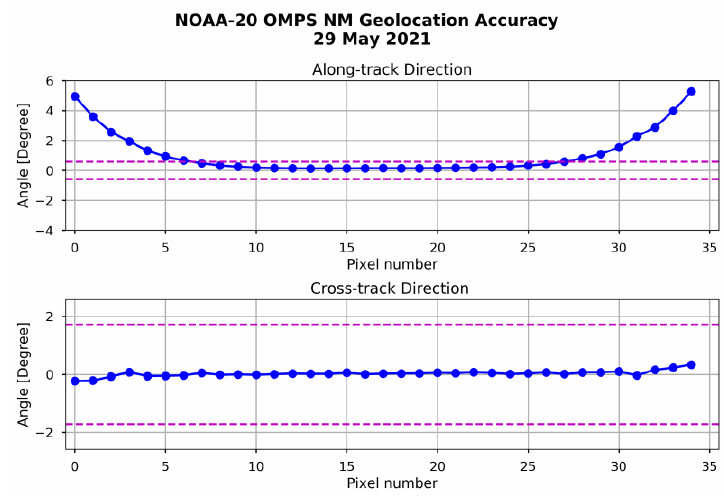
Figure 11. Geolocation assessment results, including the offset angles in the along-track and cross- track directions, where the dashed lines indicate the ± 1/2 macropixel FOV size in terms of degrees. The flowchart in Figure 12 summarizes the procedures for quantifying OMPS-NM geolocation accuracy using VIIRS M1 band geolocation fields. Both VIIRS and OMPS-NM geolocation fields on the Earth’s surface are transformed back to the S/C coordinate through inverse geolocation computation, respectively. The closed cycles indicate the perturbation procedures that generate m × n OMPS-NM LOS vectors (including FOV shapes) in the S/C coordinate. The collocation between VIIRS and OMPS-NM is carried out in the S/C coordinate. The best matched vector among the m × n (31 × 26) OMPS-NM LOS vectors is selected by examining the maximum correlation between VIIRS-collocated and real OMPS-NM radiance. Based on this best-matched vector, the offset angle in the along-track and cross-track can be equally derived to characterize the OMPS-NM geolocation accuracy at each macropixel FOV position.